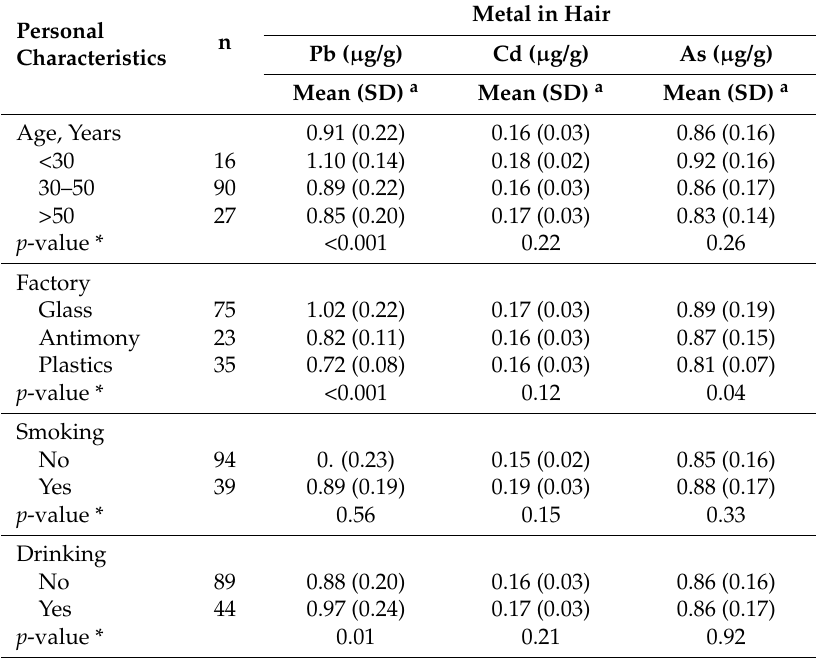
Table 1. Mean levels of As, Cd and Pb in hairs of study subjects (n = 133) by their age, job type and